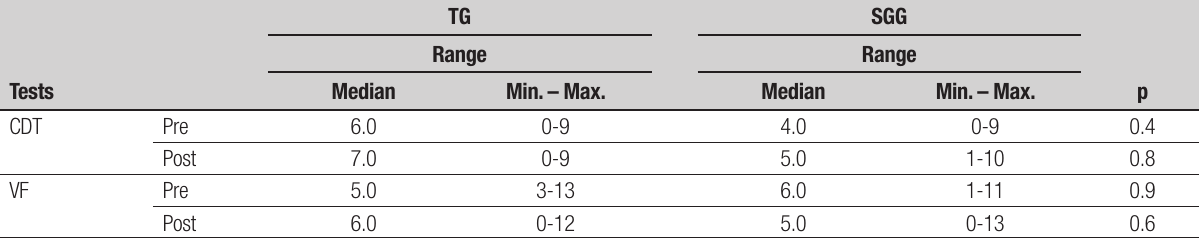
Table 3. Medians, range and p-value of Clock Drawing Test (CDT) and Verbal Fluency (VF) for Training Group (TG) and Social Gathering Group (SGG) pre and post